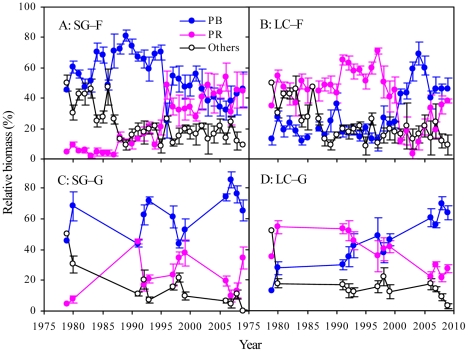
Changes in the relative biomass (%) of plant functional groups in four grasslands.The plant functional groups were classified as PB (perennial bunchgrasses), PR (perennial rhizome grass), and others. SG–F, fenced S. grandis grassland; SG–G, grazed S. grandis grassland; LC–F, fenced L. chinensis grassland; LC–G, grazed L. chinensis grassland.